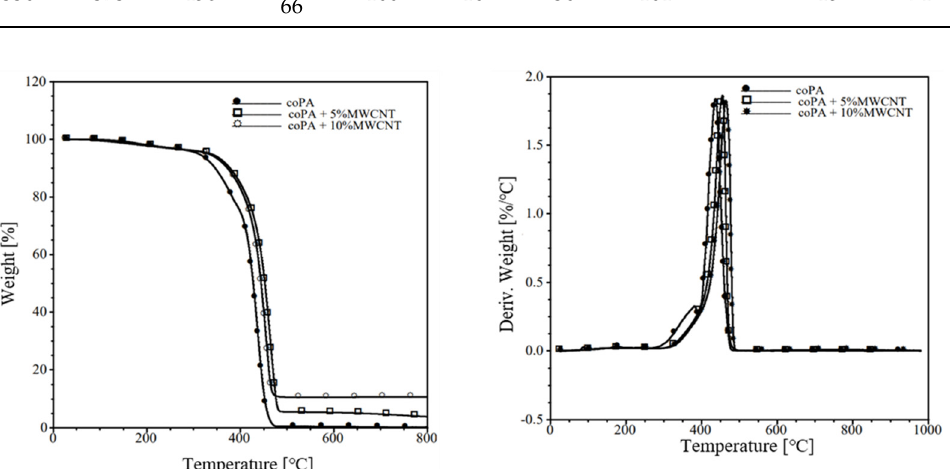
Figure 5. The TGA curves for the neat coPA and its masterbatches containing 5 wt% and 10 wt% MWCNT.